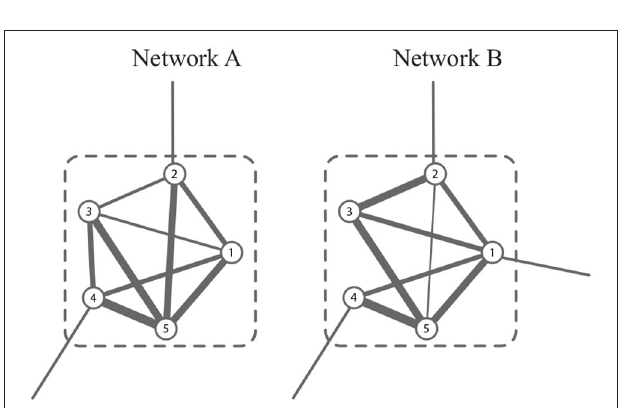
FIGURE 2 | A schematic example of common module, which is well-connected in both